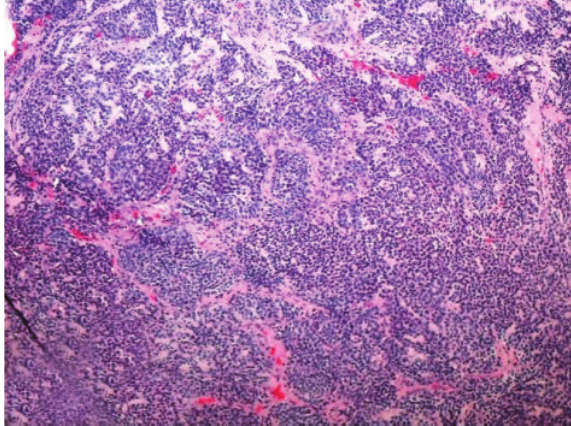
Figure 2: Pathology slide revealing a CD99+ poorly di ff erentiated trabecular neoplasm consistent with a neuroendocrine